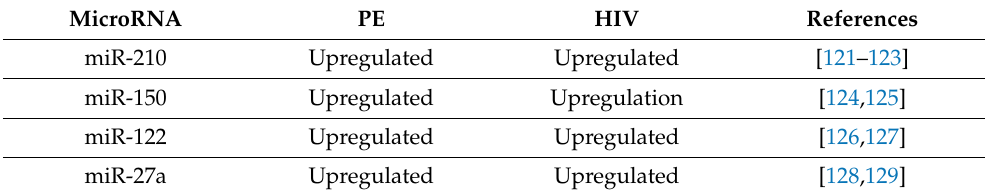
Table 2. The expression of VEGFR-2-related microRNAs commonly dysregulated in PE and HIV. MicroRNA PE